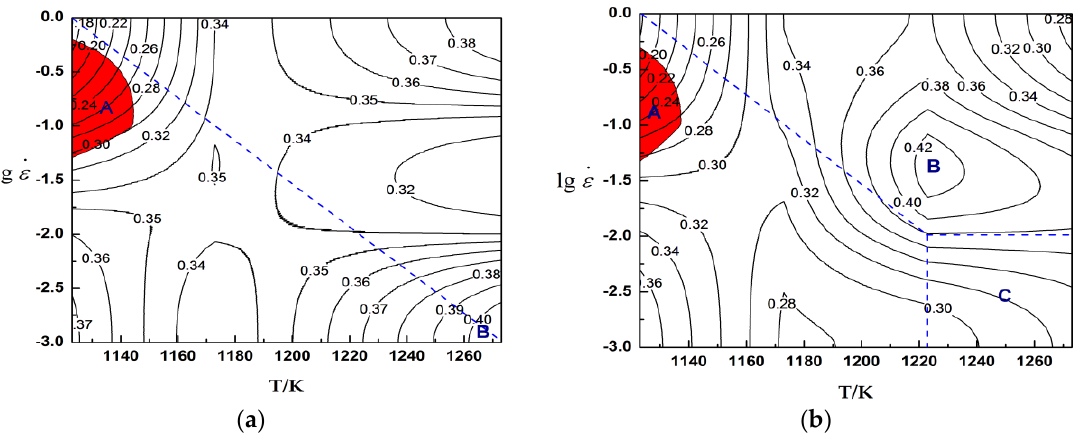
Figure 7. Processing maps of the ( a ) as-cast and ( b ) homogenized state Al 0.5 CoCrFeNi high entropy alloys (HEAs) at a true strain state of 0.8. A, B and C correspond to different regions. (A—instability regions, B—optimum thermo-mechanical processing regions, C—high temperature and low strain rate region of ( b )).